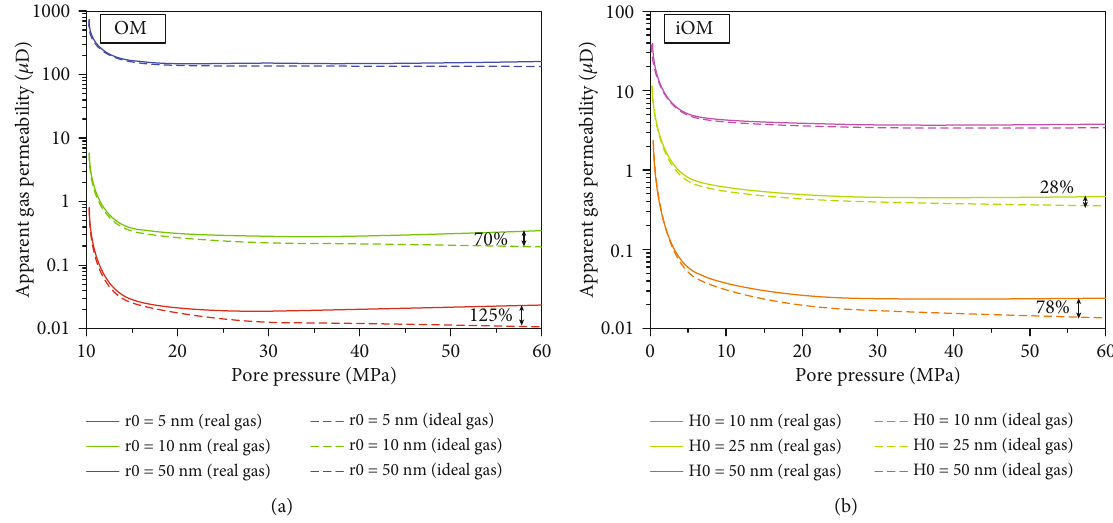
Figure 10: The AGP of (a) OM and (b) iOM varies with pore pressure for real gas and ideal gas at di ff erent pore dimensions.